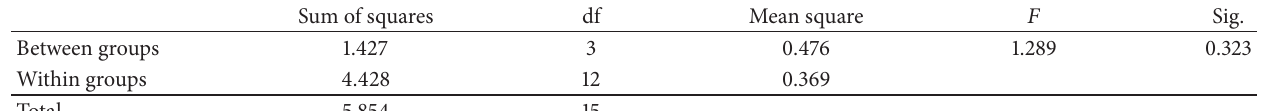
Table 1: ANOVA for collector with similar glass thicknesses.